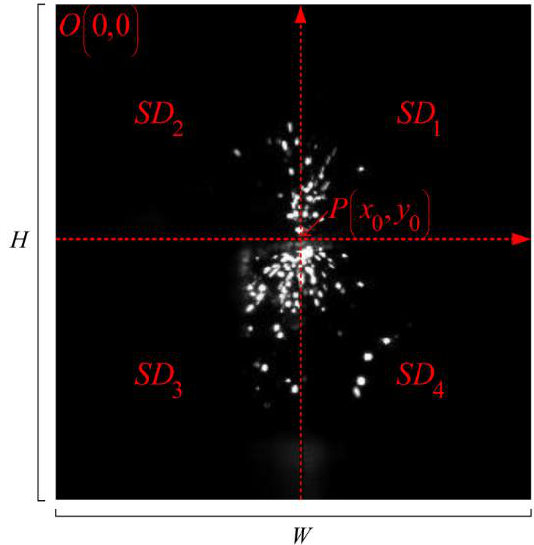
Figure 2. Spark area distribution ( SD k ).